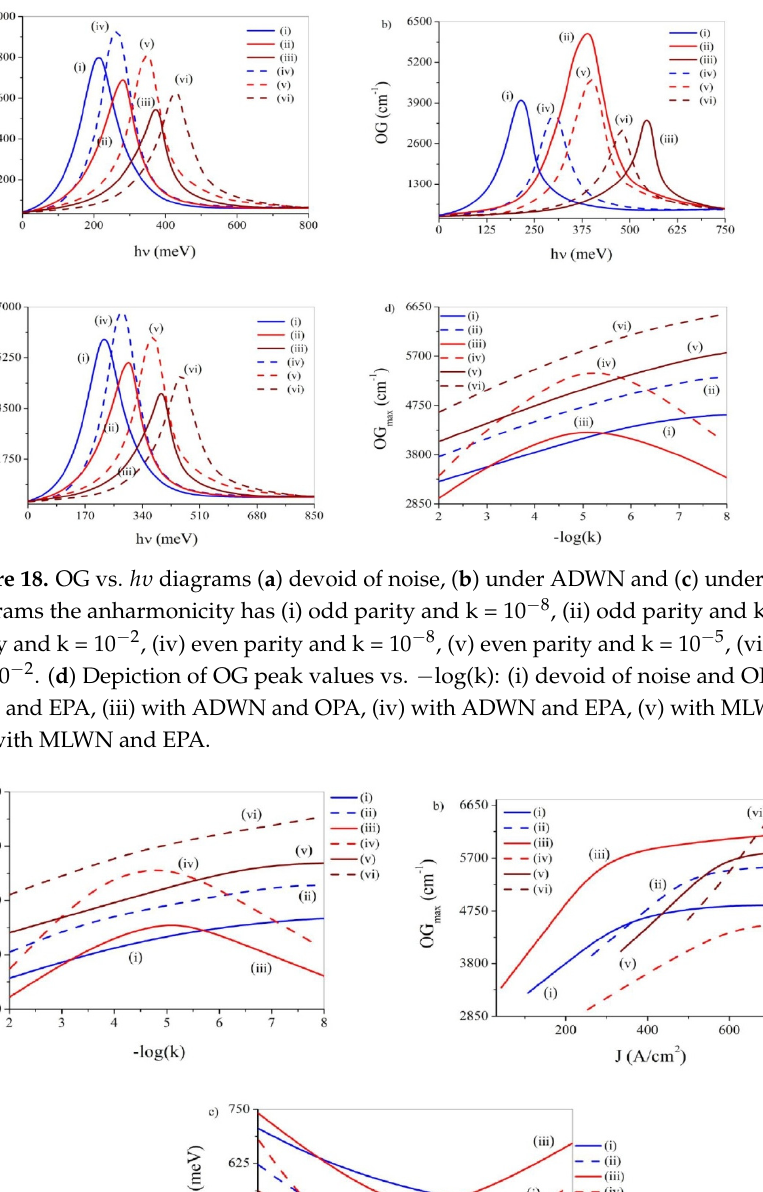
Figure 19a–c manifests the diagrams of gain radiative current density ( J ) vs. − log ( k ),